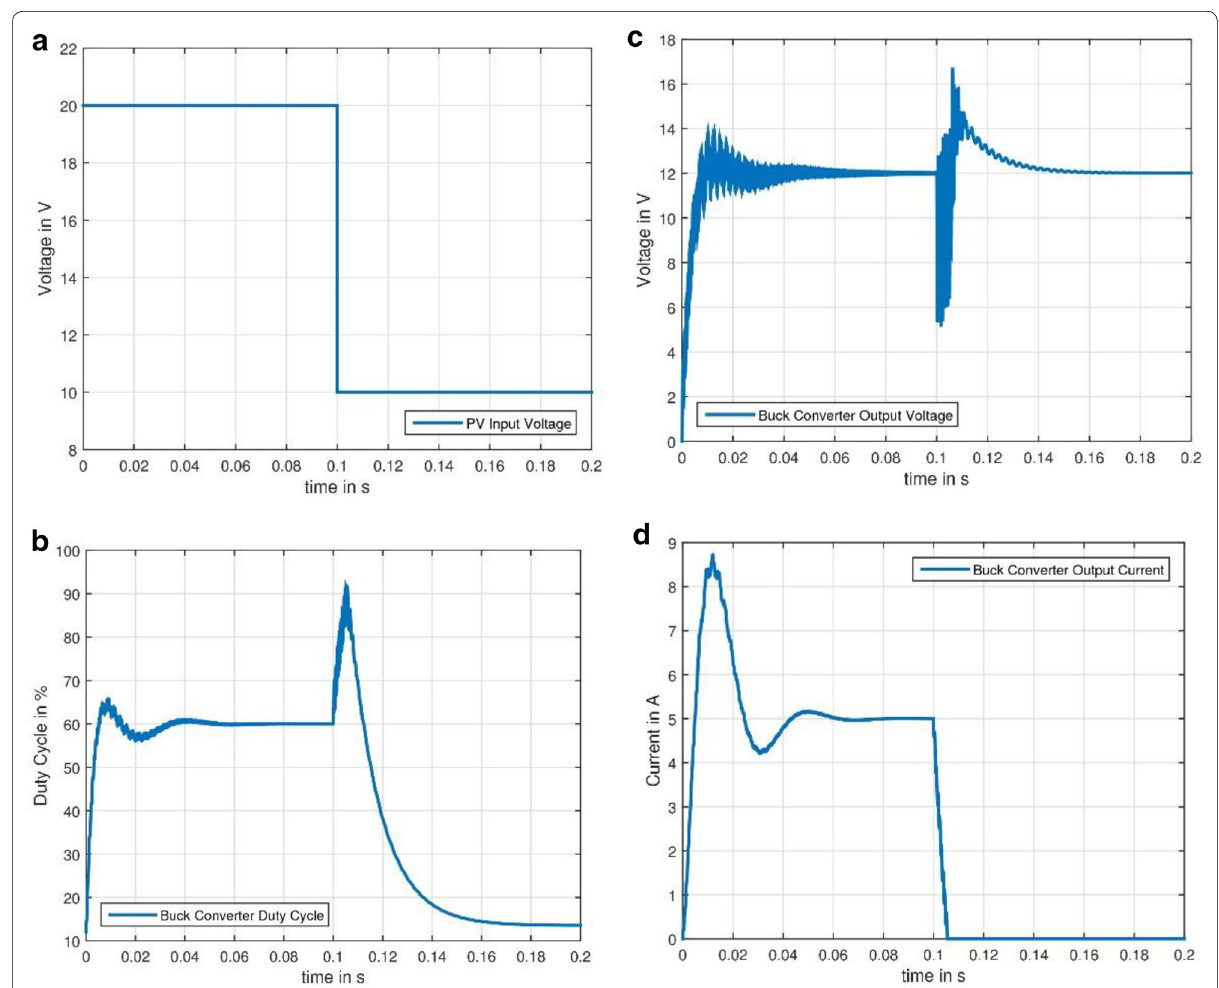
stepped down from 20 to 10 V. As a result, the buck con- verter output voltage initially was set to 12 V by 0.08 s in Fig. 5c. When the supply voltage is reduced below zero, the PV module cannot sustain the printer output of 12 V. So there is a dip in buck converter output voltage in Fig. 5c as the battery on the other side is switched from being a sink to a source. It takes about 0.05 s to recover from the change of sources. This is what it would take for an actual battery to recover from such a change. In Fig. 5d, buck converter output current was supplying the load as long as it had enough power from the PV. Initially there were some transients in Fig. 5c, d due to the induc- tor and the capacitor charging. Soon by 0.08 s the current output settled to 5 A which is the sum of requirement of the load and the battery charging current requirement. The characteristics of the battery parameters are shown in Fig. 6a–d.